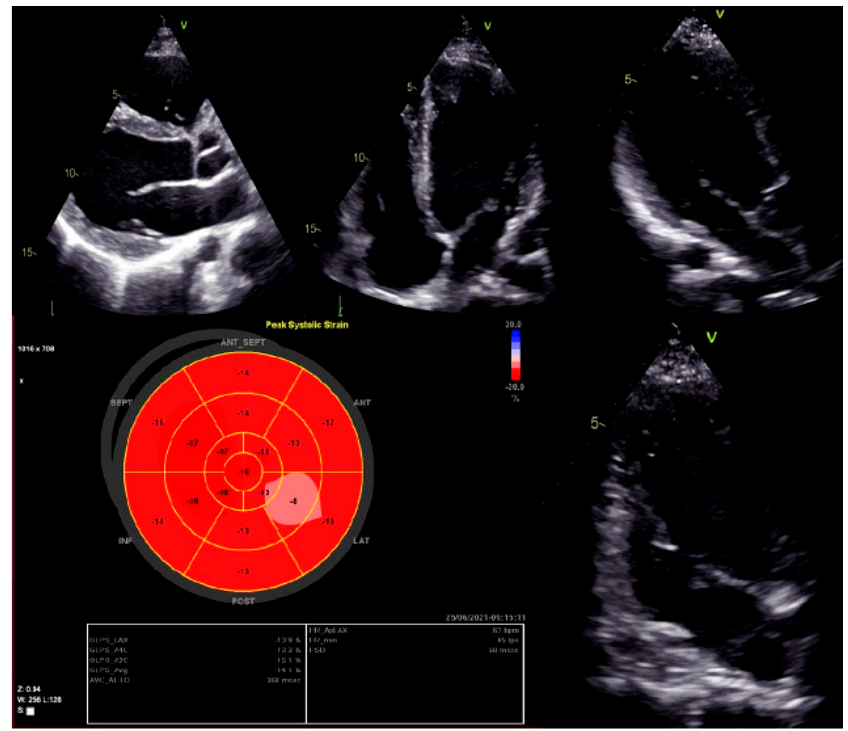
Figure 2. Left ventricular global longitudinal strain by speckle-tracking echocardiography.